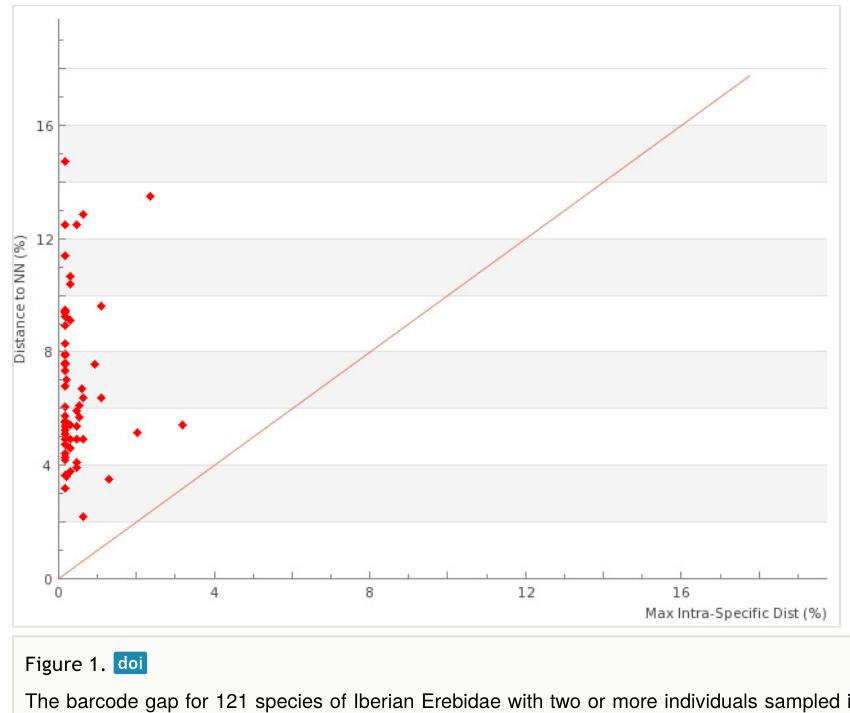
The barcode gap for 121 species of Iberian Erebidae with two or more individuals sampled is shown by plotting maximum intraspeci fi c divergence against nearest-neighbour distance. Points above the diagonal indicate species with a barcode